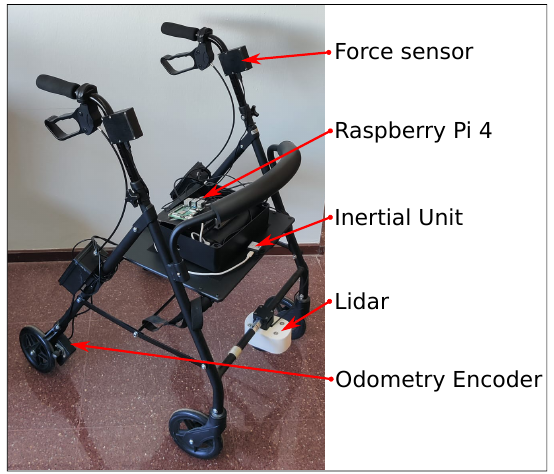
Figure 2. Kmina Comfort Rollator with proposed sensors and